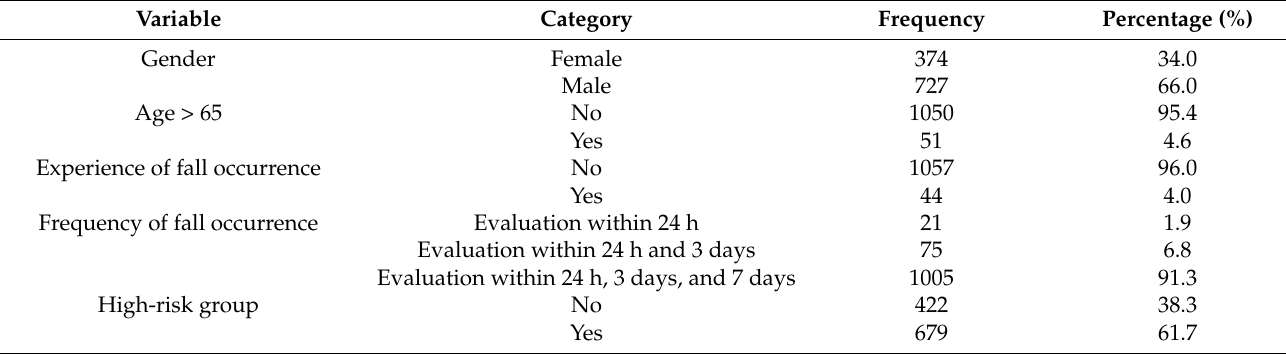
Table 1. Psychiatric patient background variables (N =